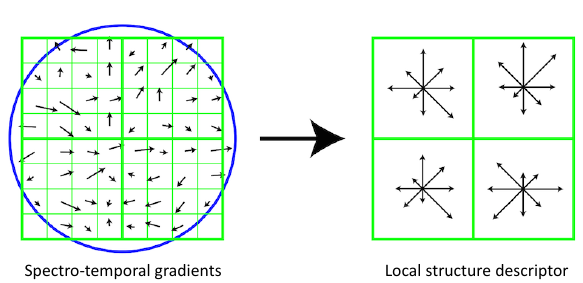
Figure 5. HOG coding scheme on spectro-temporal local regions.